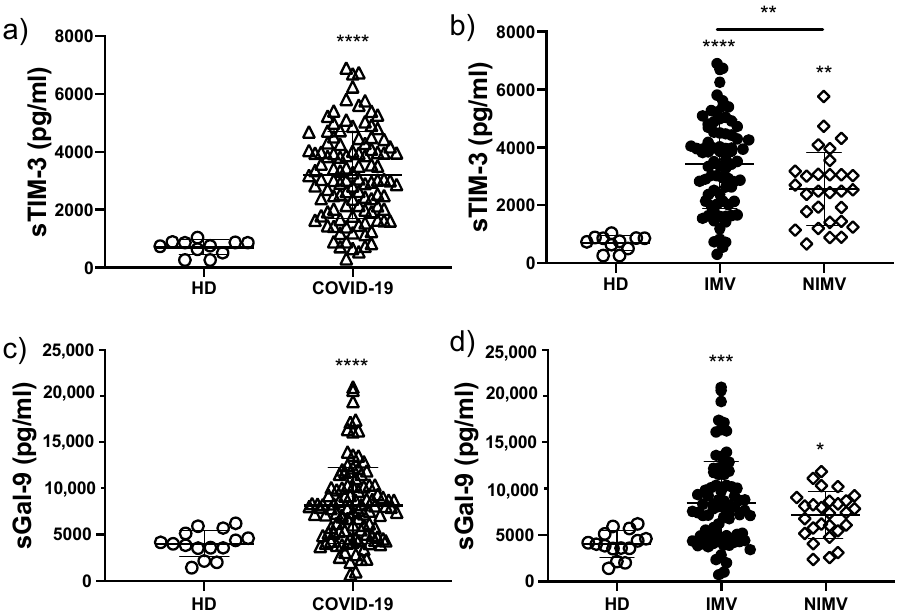
serum concentrations of sTIM-3 than NIMV patients (3431 ± 1541 vs. 2566 ± 1249 pg/mL, p < 0.01) (Figure 2b).